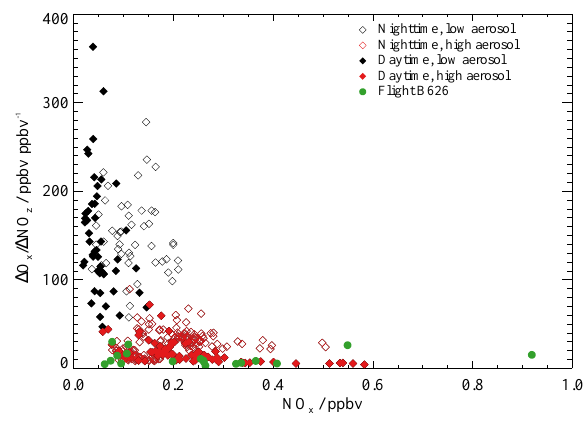
Fig. 9. Relationship between the enhancement ratio of O x to NO z ( ∆ O x / ∆ NO z ) in units of ppbvppbv − 1 and NO x mixing ratio in units of ppbv measured in boreal biomass burning plumes from the BAe-146 over the course of the BORTAS measurement campaign. Symbols are the same as those described for Fig. 8.